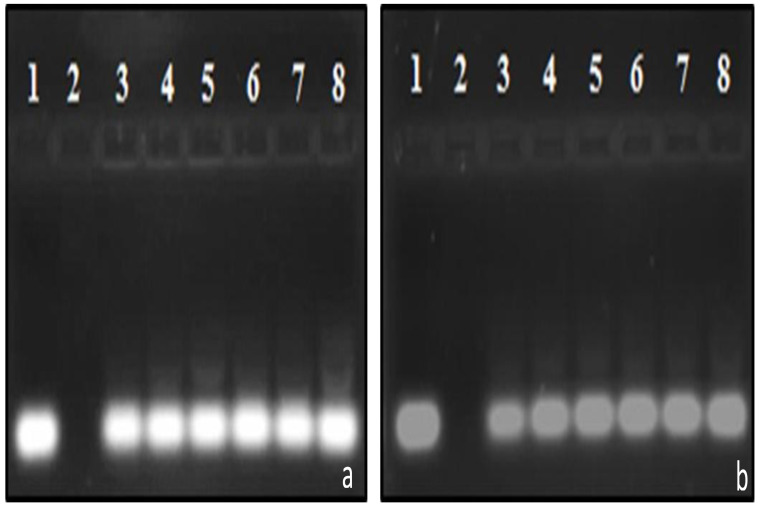
Nuclease protection capability of a) MS09/DOPE and b) MS09/Chol (1:1) liposomes in 10% fetal bovine serum for 4 h at 37 °C.In each gel, lane 1 contained undigested siRNA, lane 2, serum-digested siRNA and lanes 3–8, serum-exposed lipoplexes at varying MS09:siRNA (12:1 – 32:1
w/
w) ratios.